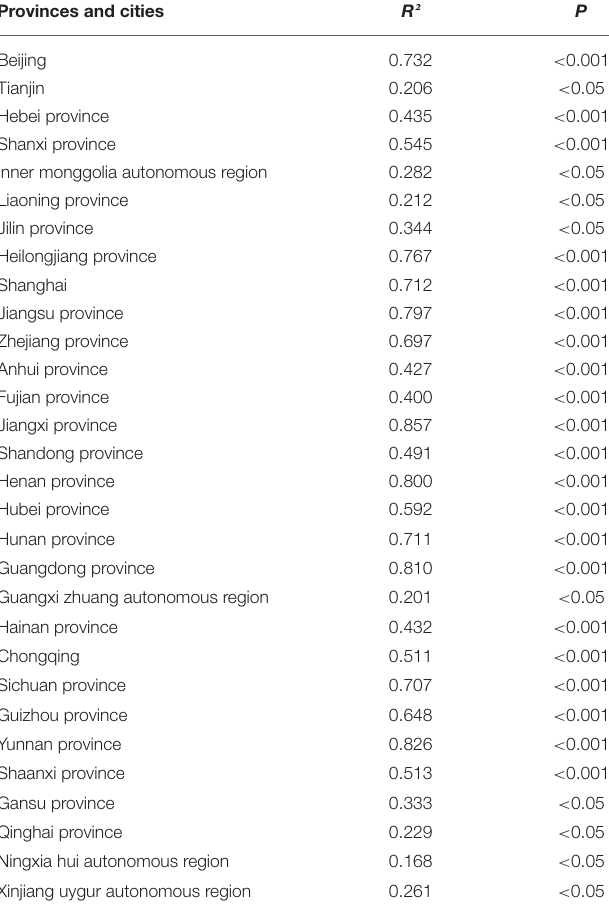
TABLE 2 | The results of goodness-of-fit in China. Provinces and